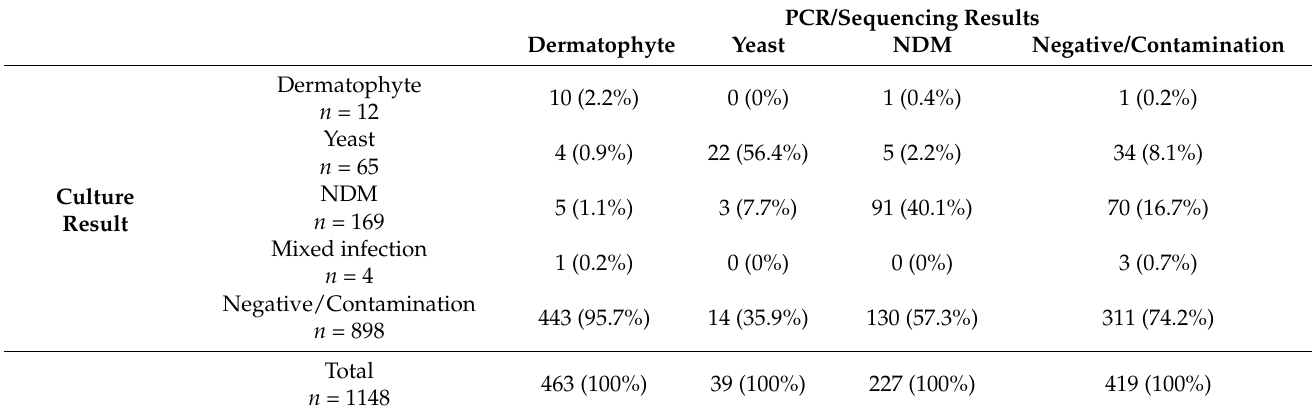
Table 2. Comparison of culture and PCR/sequencing results from the same primary nail specimen in 1148 patients. PCR/Sequencing Results Dermatophyte Yeast NDM